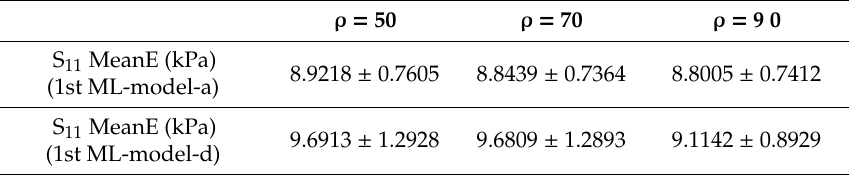
Table 1. E ff ect of ρ on the accuracy of predicted TAV leaflet stress fields ( ρ = 50, 70, 90).